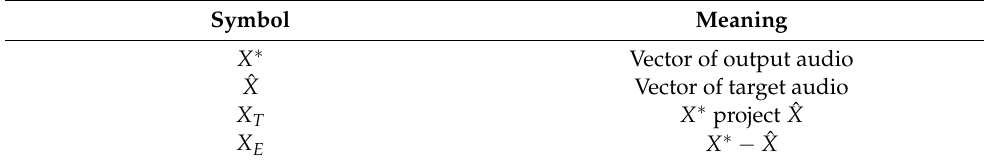
Table 2. Meaning of SDR symbol.